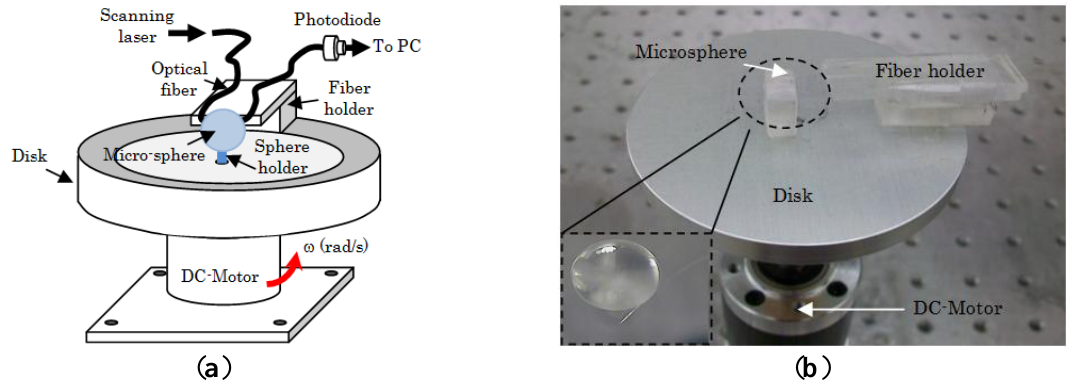
Figure 5. ( a ) Schematic and ( b ) photograph of the experimental